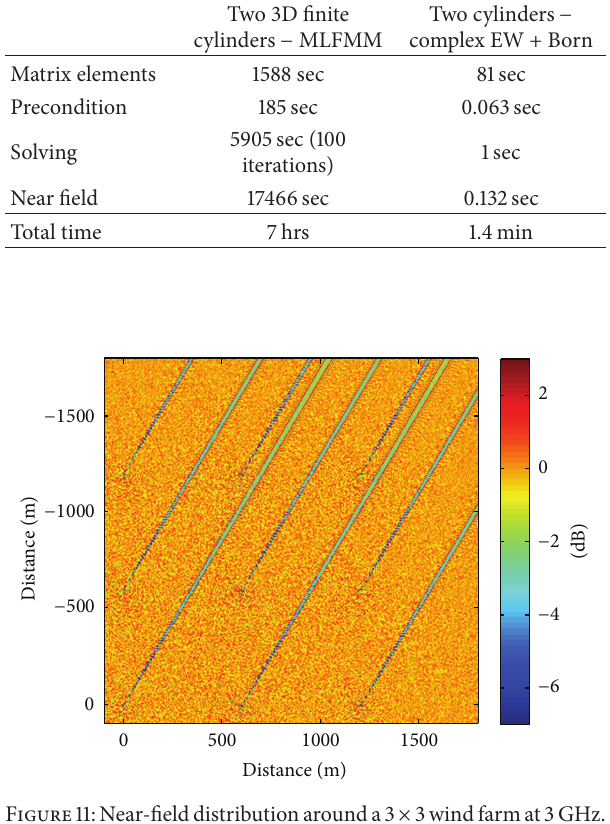
Figure11:Near-fielddistributionarounda3 × 3windfarmat3